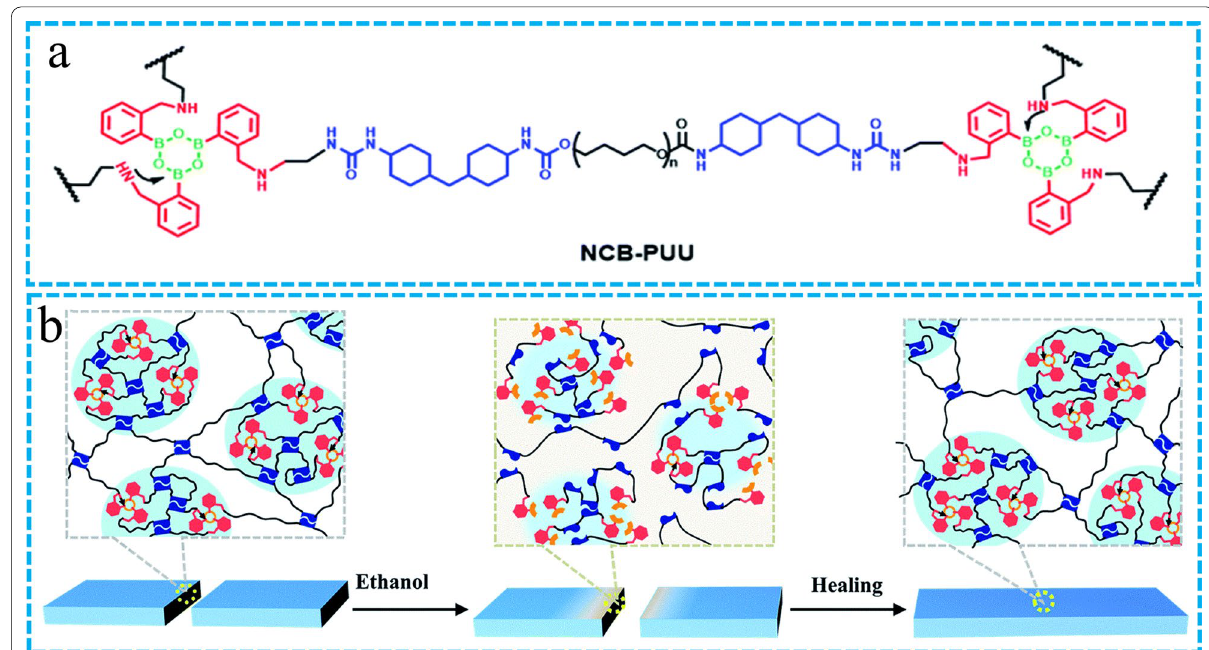
Fig. 6 a Chemical structure of the NCB-PUU. b Schematic diagram of the healing mechanism. Reprinted with permission form Reference